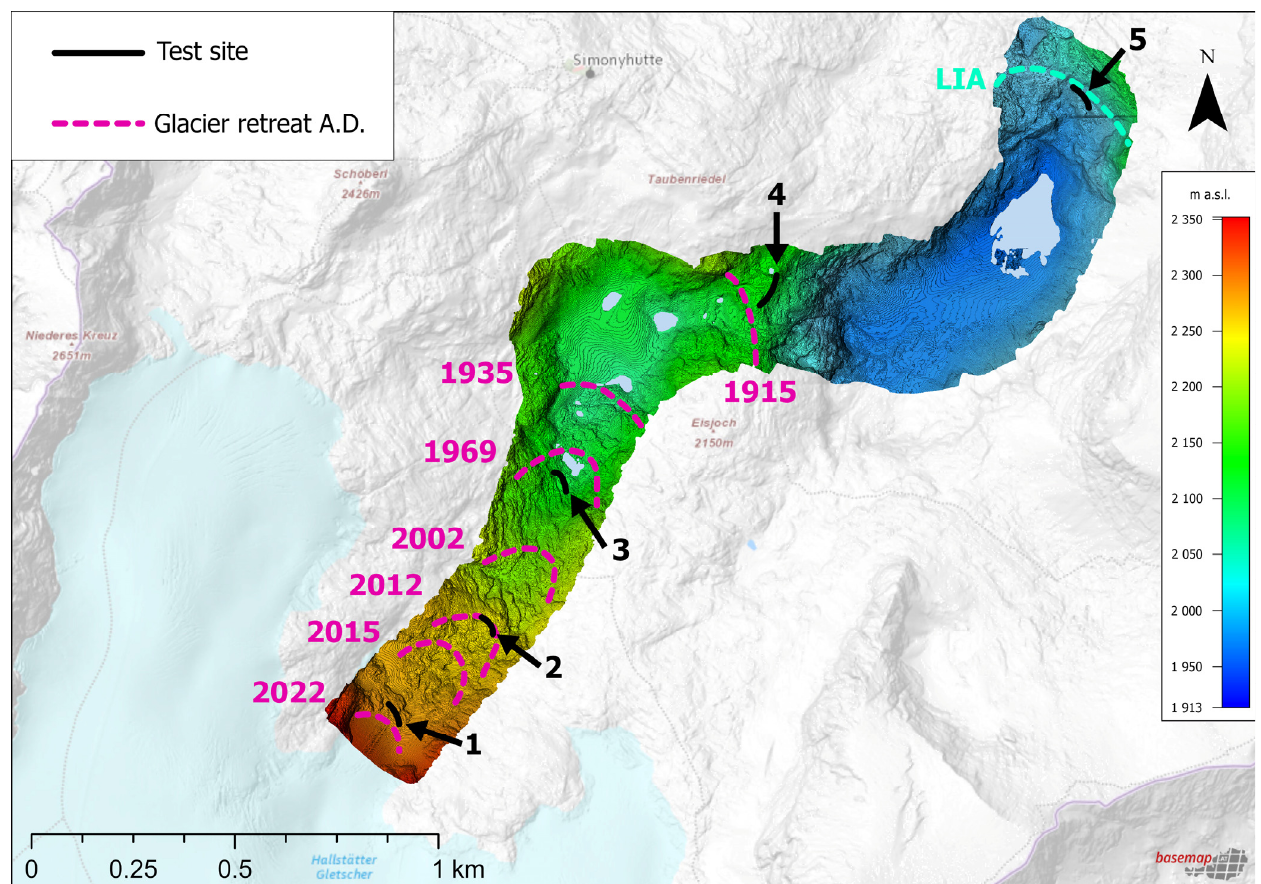
Figure 1. Location of the test sites in the Hallstätter Glacier foreland; pink dashed lines mark consecutive positions of the glacial snout (background DEM data source: basemap.at ); DEM of the glacial trough under study based on own UAV survey; glacial retreat and LIA limit after Bruhm et al. [30], Fischer et al. [31,32], and Buckel and Otto [33].